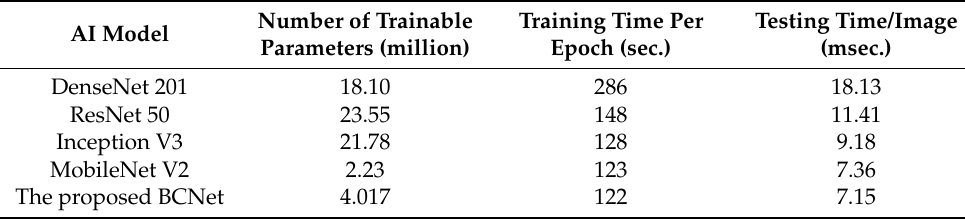
Table 3. Performance comparison of the proposed BCNet against the latest AI models with respect to the number of the learning parameters and the computation